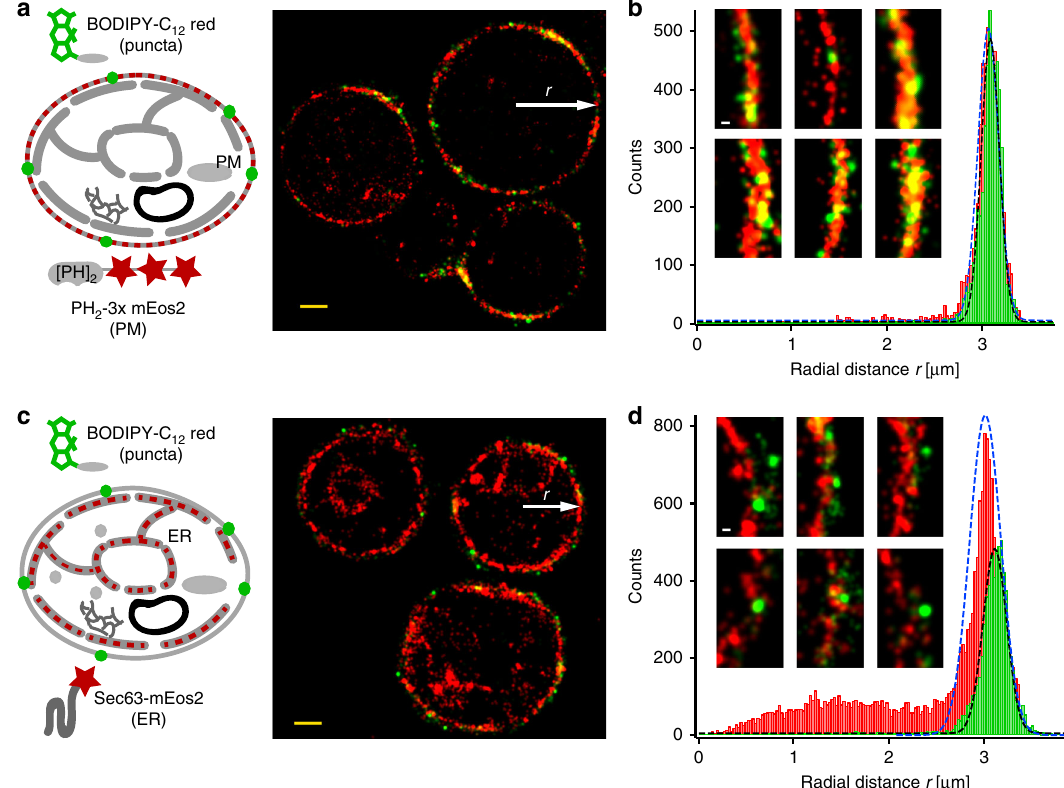
Fig. 5 Two color SMLM reveals co-localization of fatty acid analog puncta with the plasma membrane in fasting cells. a Sequential SMLM imaging of D II - BODIPY-C 12 red puncta and a double PH domain of PLCdelta(1) fused to 3x mEos2 shows co-localization of fatty acid puncta with the plasma membrane in fasting cells. b The radial distance histogram of BODIPY-C 12 red and PH 2 -3xmEos2 localizations from fi ve cells (scaled to the same radius) con fi rms the co- localization with no detectable separation outside the localization error. The insets show magni fi cations of rendered SMLM images and overlap of BODIPY- C 12 red puncta with the plasma membrane. c Sequential SMLM imaging of D II -BODIPY-C 12 red puncta and Sec63-mEos2 shows no co-localization of fatty acid puncta with the cortical ER close to the plasma membrane. d The radial distance histogram of BODIPY-C 12 red and Sec63-mEos2 localizations from fi ve cells (scaled to the same radius) reveals a mean separation of fatty acid puncta from the ER of ~100 nm. The insets show magni fi cations of rendered SMLM images and the separation of BODIPY-C 12 red puncta from the ER. Scalebar: 1 µ m; insets 100